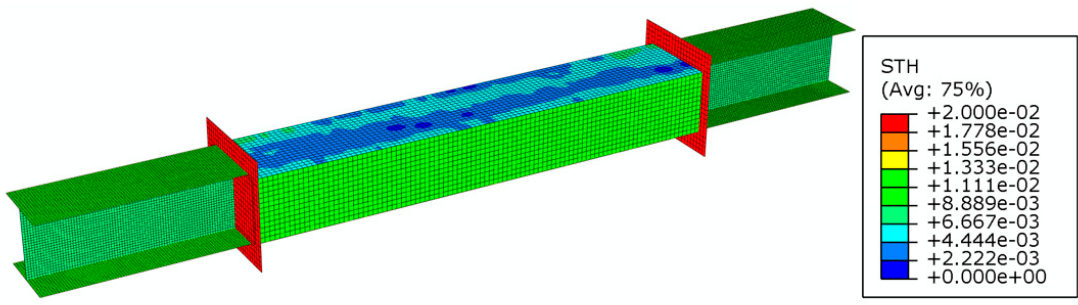
Figure 7. Shell element thickness (STH) map for a sample beam section (m).